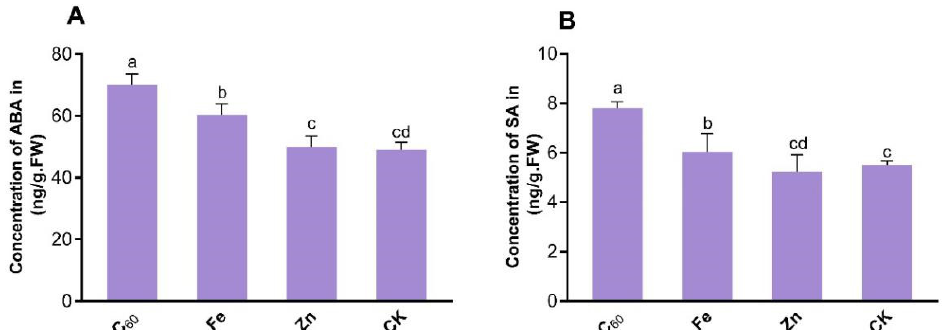
Figure 3. The concentration of phytohormones (ABA and SA) in the tobacco leaves treated with C 60 , Fe 3 O 4, and ZnO-based MNOs, ( A ) abscisic acid (ABA), and ( B ) salicylic acid (SA). p < 0.05, n = 3). Lowercase letters are Nanoparticle formula. Fullerene (C60).